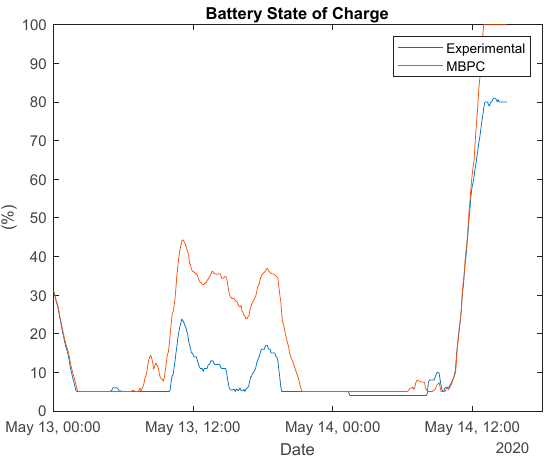
Figure 14. Battery State of Charge (cloudy day). Due to the different control algorithms, the power profiles extracted from the grid and exported to the grid are the ones shown in Figure 15.